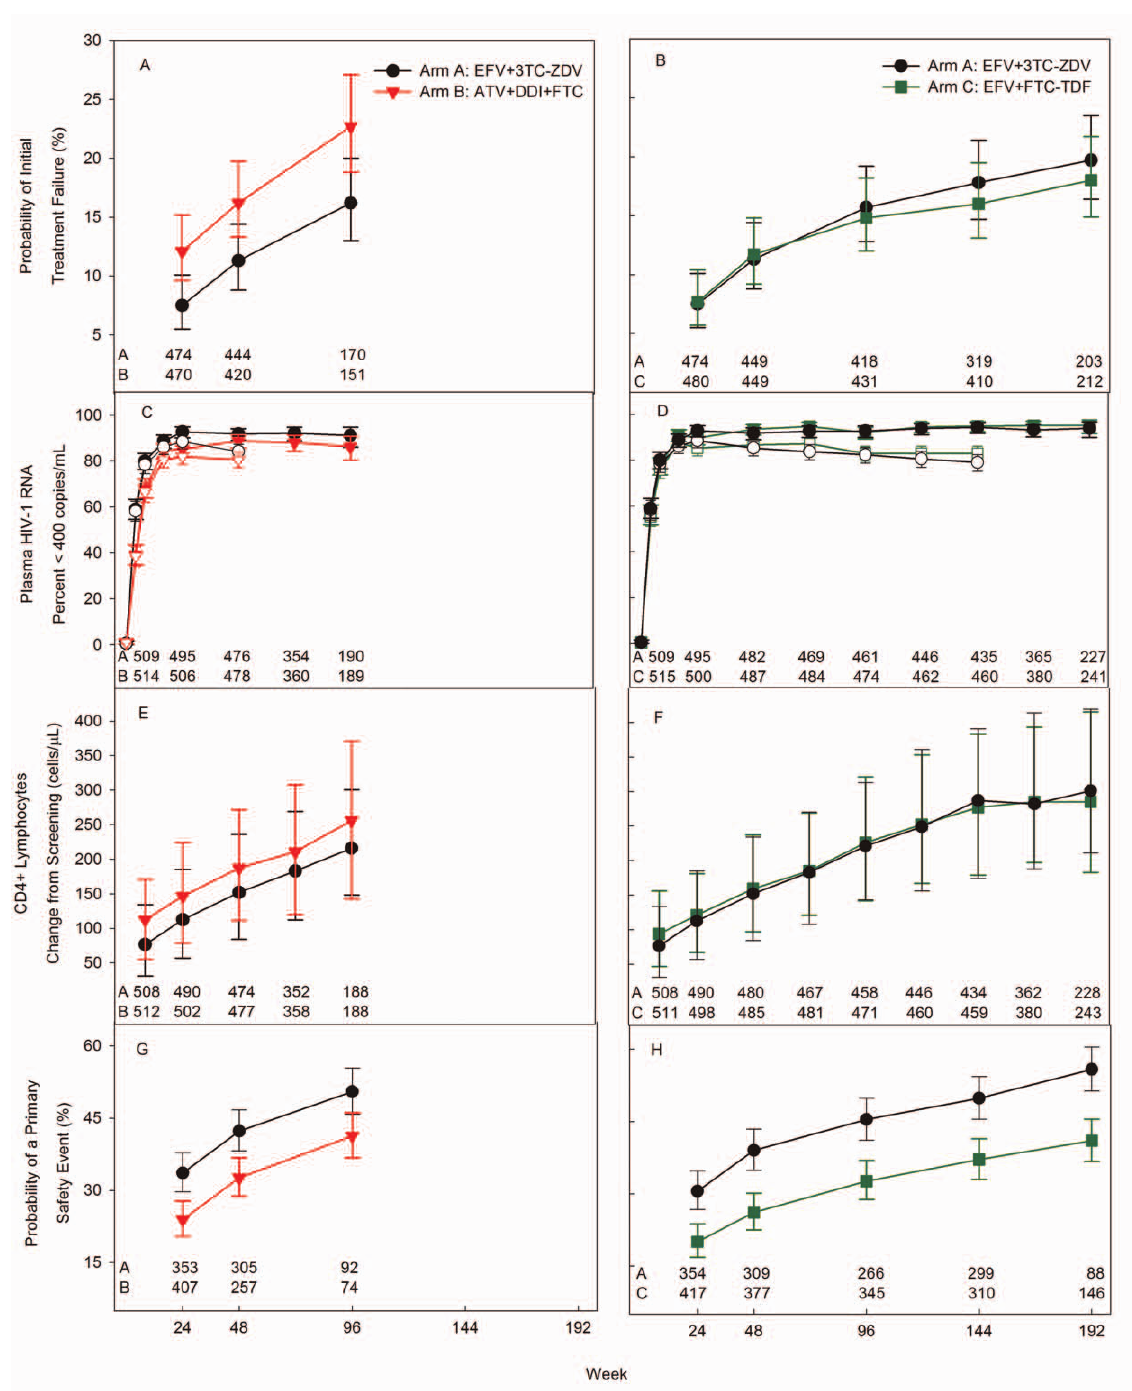
Figure 2. Efficacy and safety of randomized study treatment over time. (A–H) black circles, EFV plus 3TC-ZDV; red triangles, ATV plus DDI-EC and FTC; green squares, EFV plus FTC-TDF. (A–B) Estimated cumulative probability of antiretroviral regimen failure defined by the protocol-specified primary efficacy endpoint: comparison of EFV plus 3TC-ZDV to ATV plus FTC and DDI (A) and EFV plus FTC-TDF (B). (C–D) Proportion of participants with plasma HIV-1 RNA less than 400 copies/ml for comparison of EFV plus 3TC-ZDV to ATV plus FTC and DDI (C) and EFV plus FTC-TDF (D). These comparisons included all randomized study participants according to assigned study treatment. The analysis that counted missing values as greater than 400 copies/ml (open symbols) is truncated at the maximum potential duration of study follow-up for participants who entered the study at the end of the enrollment period (144 wk). (E–F) Median change in CD4 + lymphocyte count from screening value over time for comparison of EFV plus 3TC-ZDV to ATV plus FTC and DDI (E) and EFV plus FTC-TDF (F). (G–H) Estimated cumulative probability a safety endpoint over time for comparison of EFV plus 3TC-ZDV to ATV plus FTC and DDI (G) and EFV plus FTC-TDF (H). For (A–D, G and H), bars represent the 95% CI for the estimate. For (E–F), bars represent the interquartile range. (A–H) The number of evaluable participants at each time point is provided for each randomized treatment assignment.